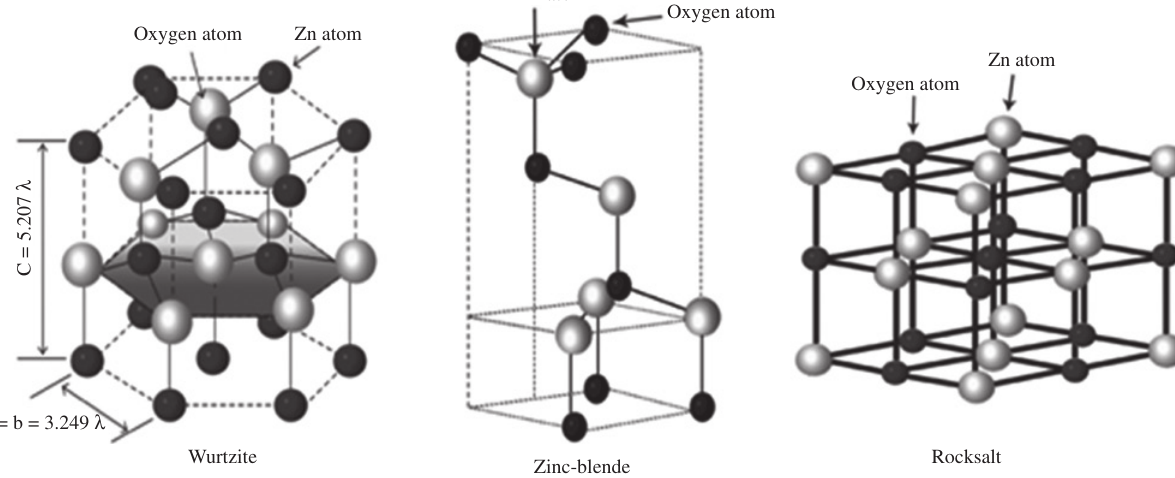
Figure 4: ZnO crystal structures of wurtzite (tetrahedral coordination of ZnO), zinc blende, and rock salt. Revised from Sirelkhatim et al.